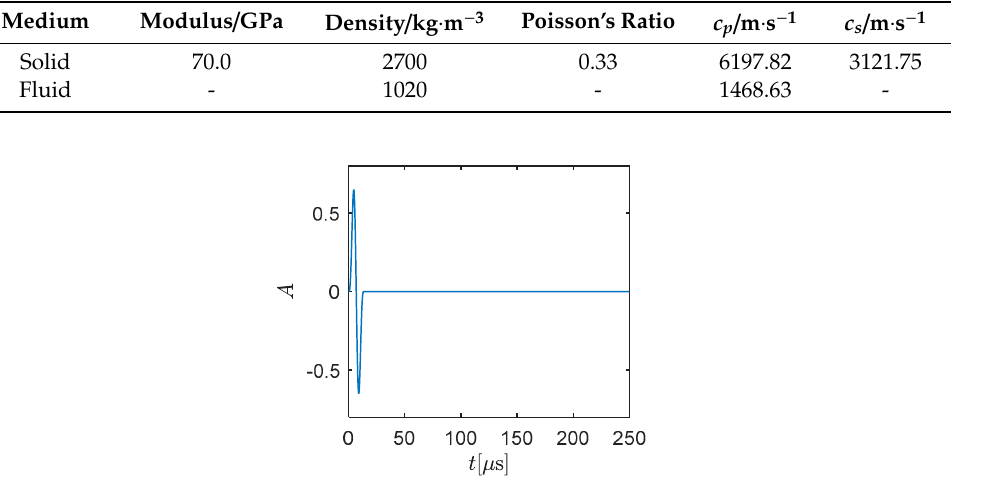
Figure 2. The excitation used in simulations.